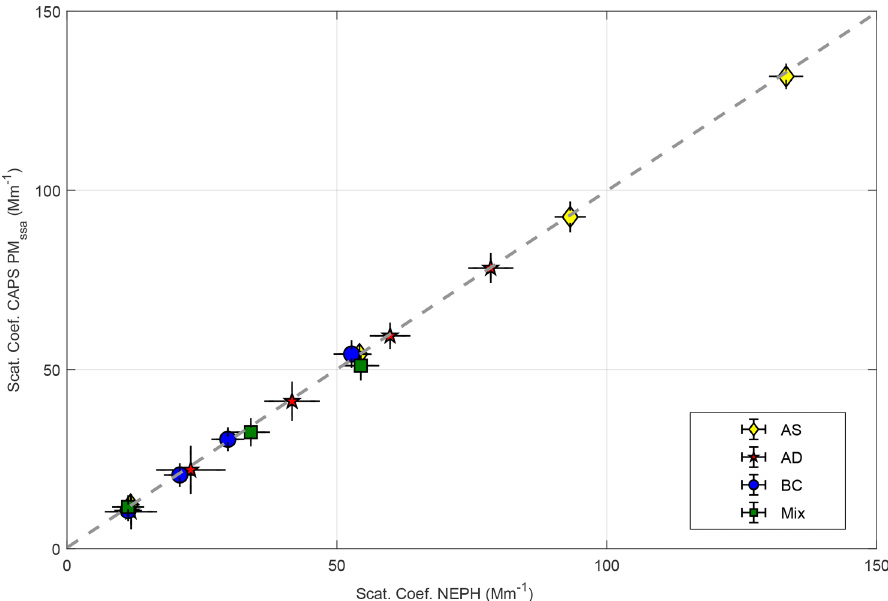
Figure 9. Comparison result (mean value and standard deviation for each level) of the scattering channel of the CAPS PM SSA with the measurements from the NEPH for the different aerosol types (dashed line is the identity line, i.e., 1 : 1